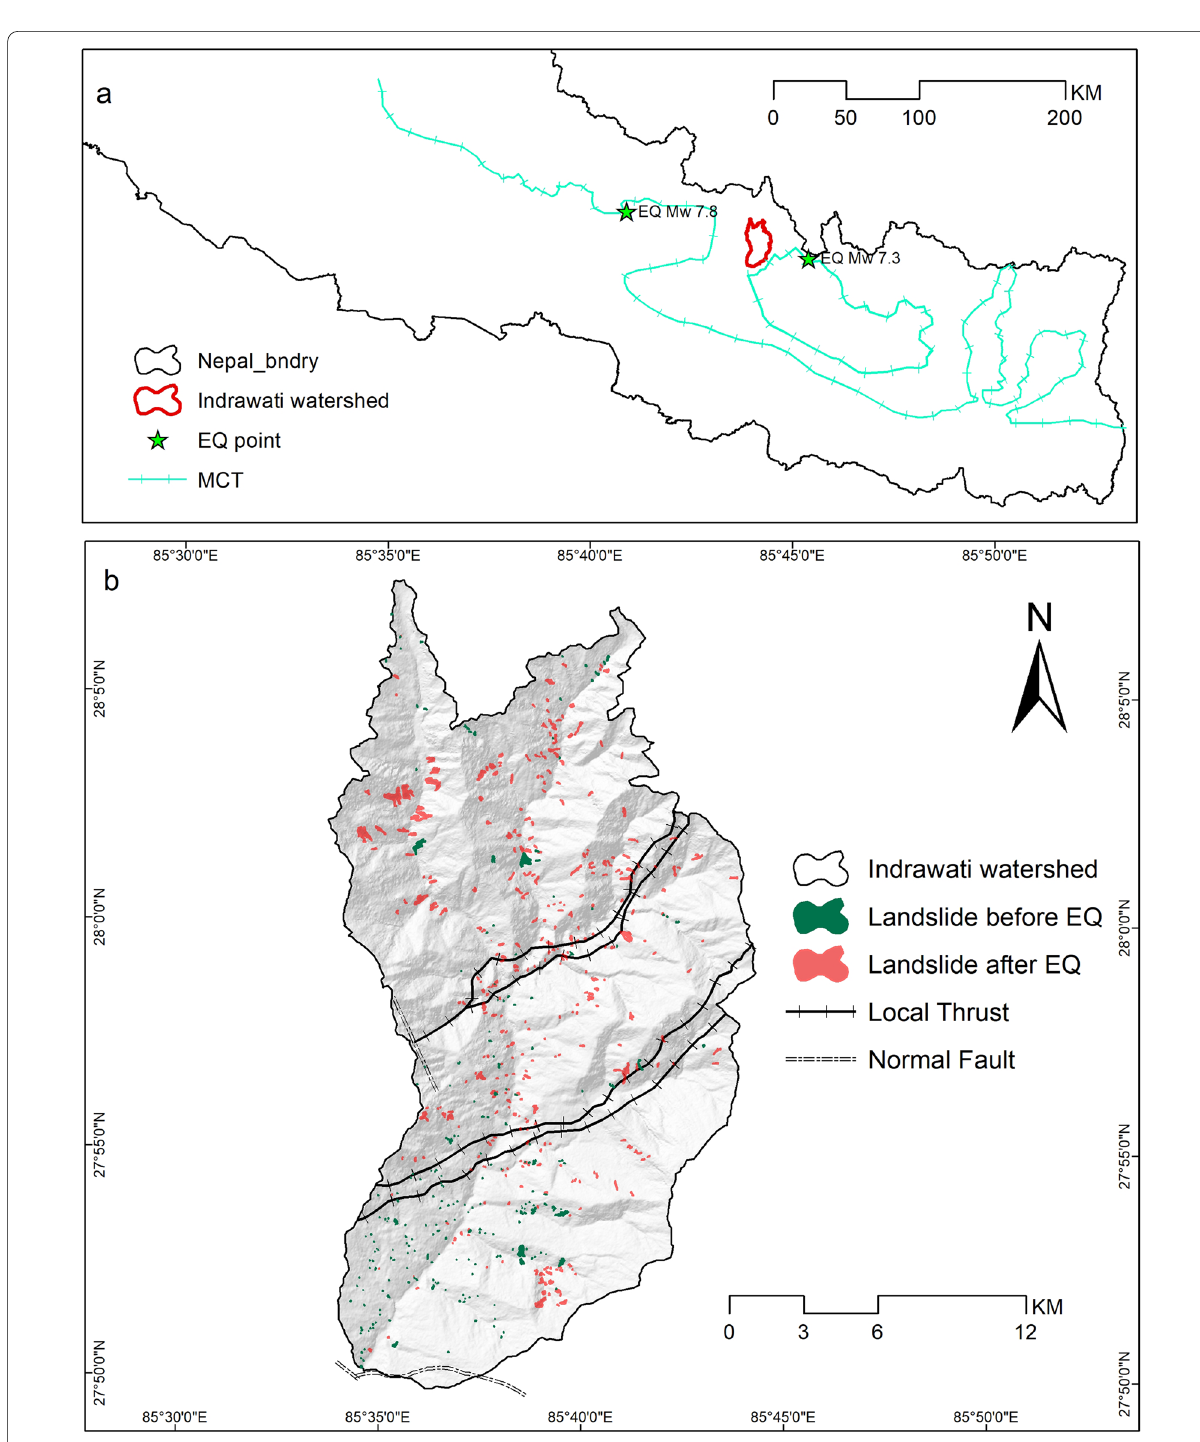
Fig. 1 Map of study area (Indrawati watershed): a MCT (modified after Dahal 2006), earthquake epicenter (at Main Himalayan Thrust), and b rainfall-induced landslides adopted from Gautam et al. (2021) and earthquake-induced landslides along with normal fault and